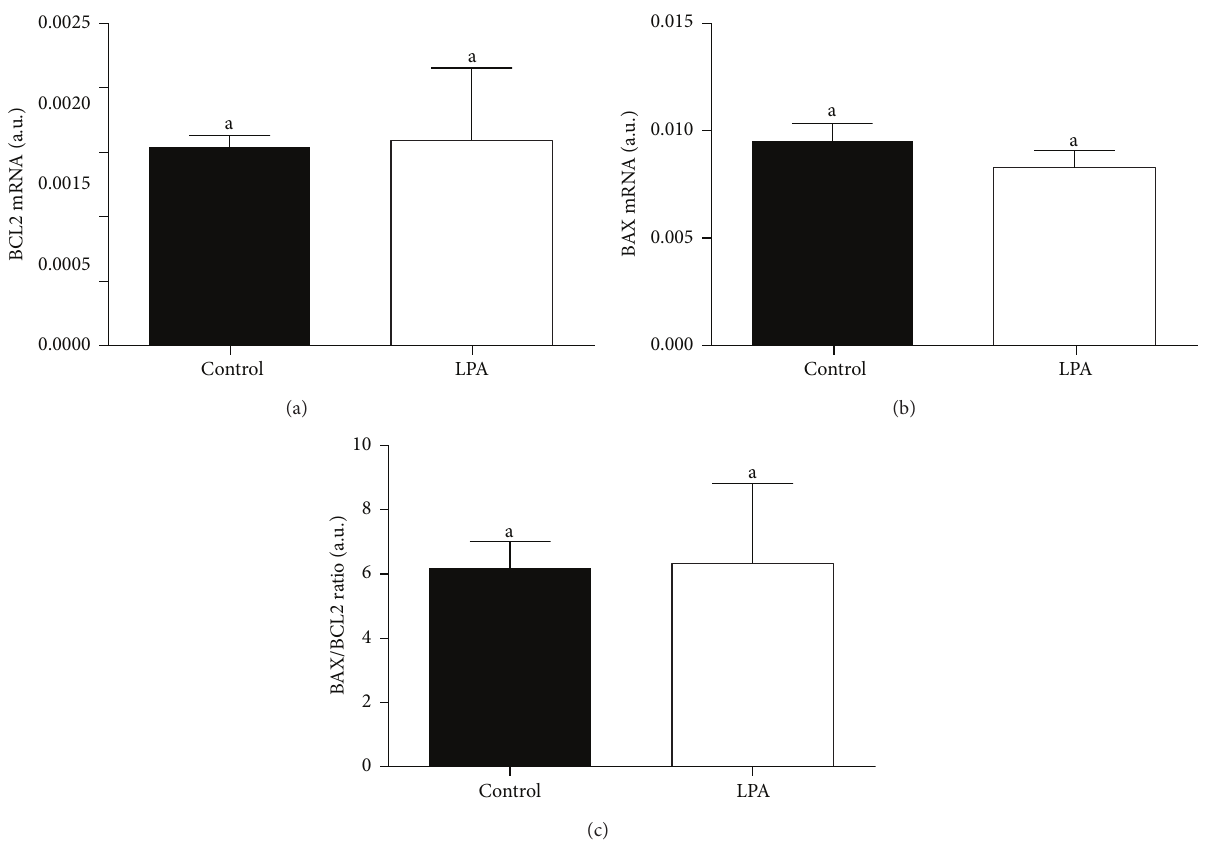
Figure 6: The effect of LPA (10 −5 M) supplementation of maturation medium on mRNA abundance of BCL2 (a), BAX (b), and BAX/BCL2 ratio (c) in cumulus cells. The values are expressed as mean ± SEM. Different letters indicate significant differences ( 𝑃 < 0.05 ), as determined by Student’s 𝑡 -test.